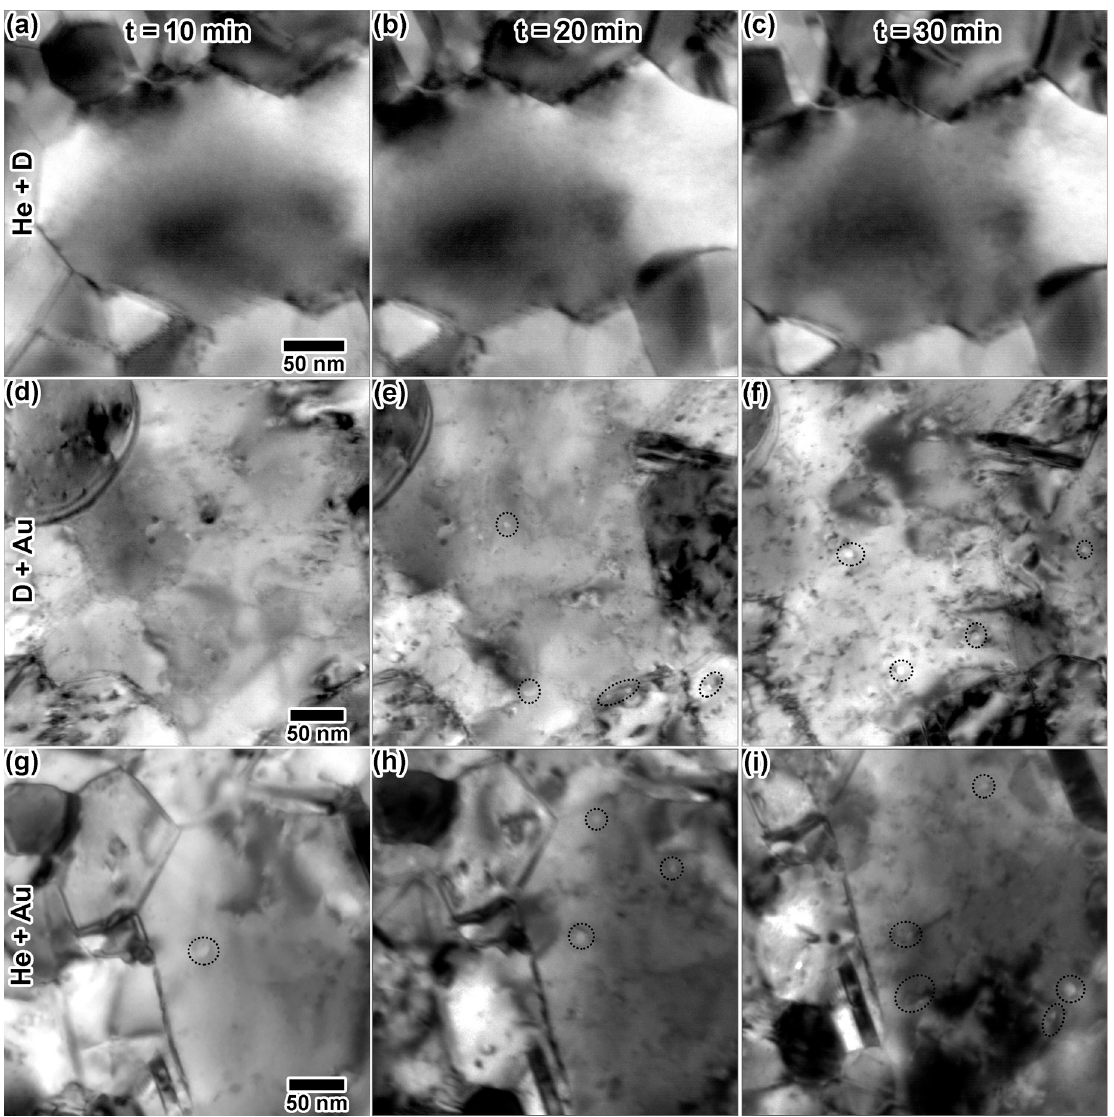
Figure 8. In situ TEM images from double beam irradiations: ( a – c ) 10 keV He + 5 keV D; ( d – f ) 1.7 MeV Au + 5 keV D and ( g – i ) 1.7 MeV Au + 10 keV He after 10, 20 and 30 min. Dashed circles highlight possible cavity formation. At 30 min, irradiation doses were as follows: (c) 8.88 × 10 16 D/cm 2 and 4.44 × 10 16 He/cm 2 , 1.1 D dpa and 2.7 He dpa, 19.35 at % D and 9.22 at % He, (f) 1.42 × 10 17 D/cm 2 and 1.88 × 10 11 Au/cm 2 , 1.8 D dpa and 0.005 Au dpa, 30.94 at % D, and (i) 1.54 × 10 17 He/cm 2 and 7.5 × 10 11 Au/cm 2 , 9.2 He dpa and 0.02 Au dpa, 31.97 at % He. All TEM images were taken at the same magnification.